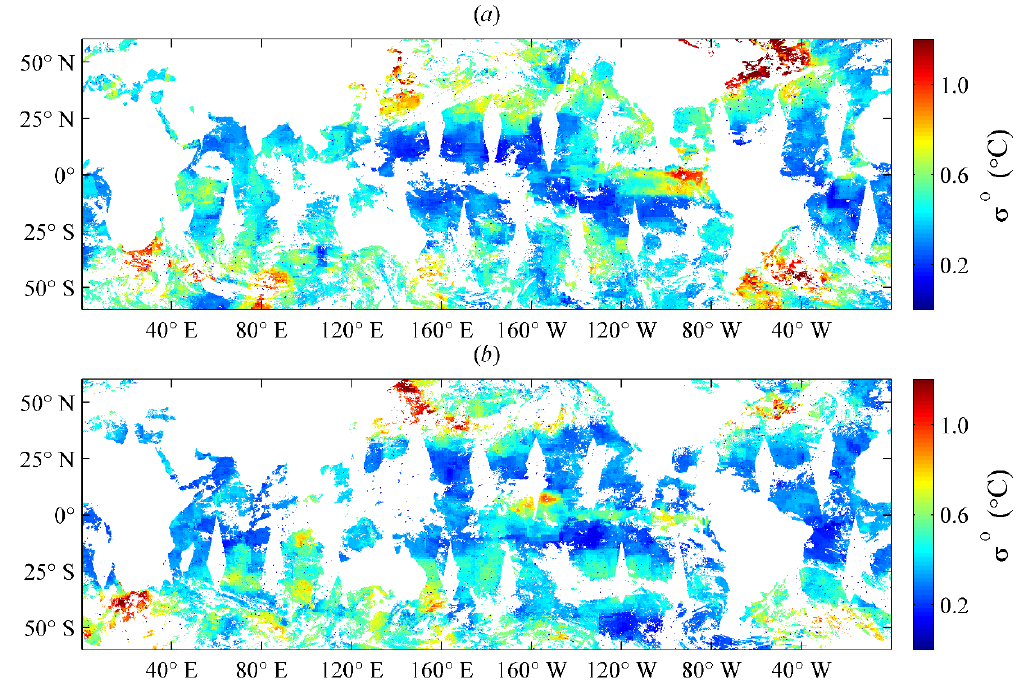
Figure 5. Distributions of SST observation field error on ( a ) 1 May 2016, and ( b ) 1 October 2016.